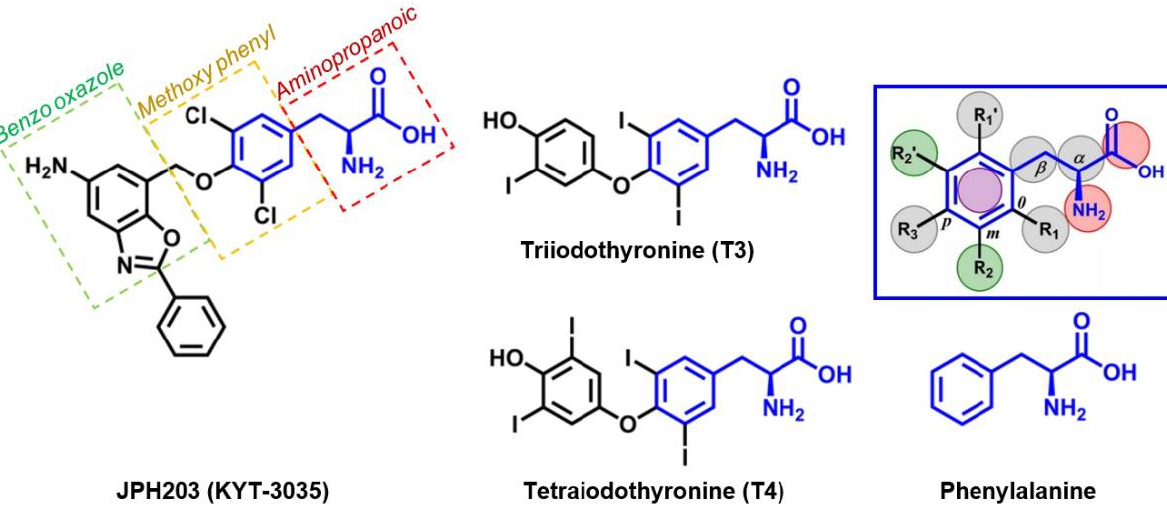
Figure 2. The structure of JPH203, T3, T4, and phenylalanine. The same group is marked in blue. The JPH203 framework consists of three basic parts [43]. Blue box: The structure-activity relationship (SAR) from the L -phenylalanine. The positions of the two α –amine and α –carboxyl (red circle) groups are held sterically. The position of the aliphatic portion of the side chain marked α and β (gray circle) is tolerating modifications. The aromatic rings of the side chains are marked with a purple circle and their positions include ortho ( 0 , R1, and R1’), meta ( m , R2, and R2’), and para ( p , R3). All positions in the aromatic chain can tolerate modification and steric mass, but meta positions are important for affinity